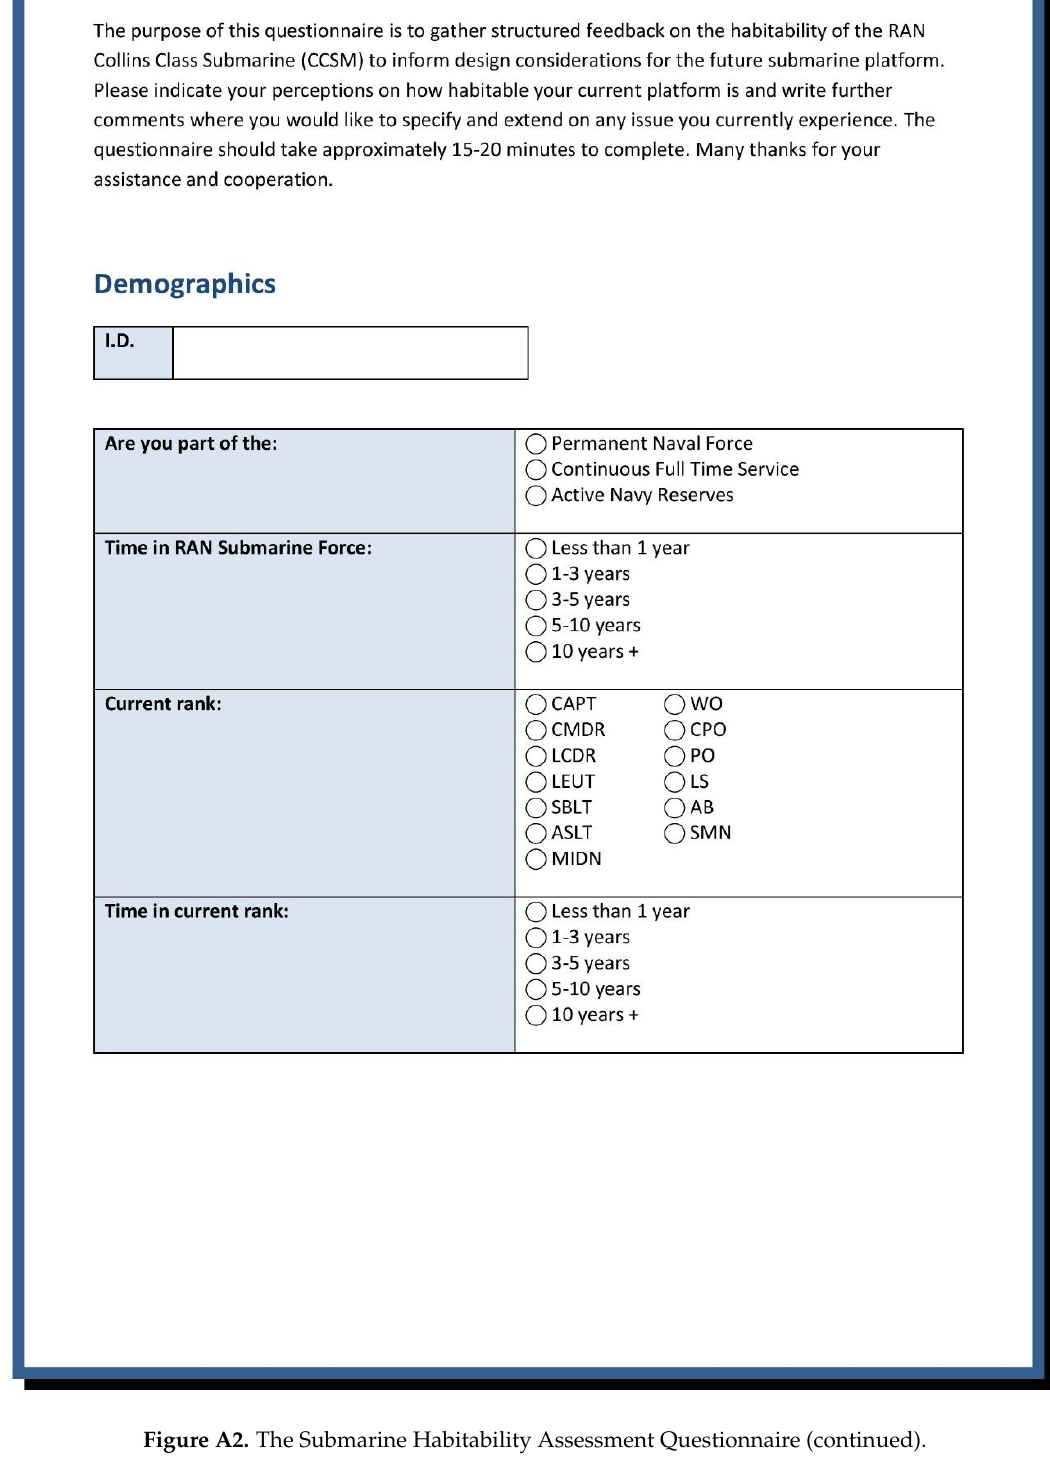
Figure A2. The Submarine Habitability Assessment Questionnaire (continued).